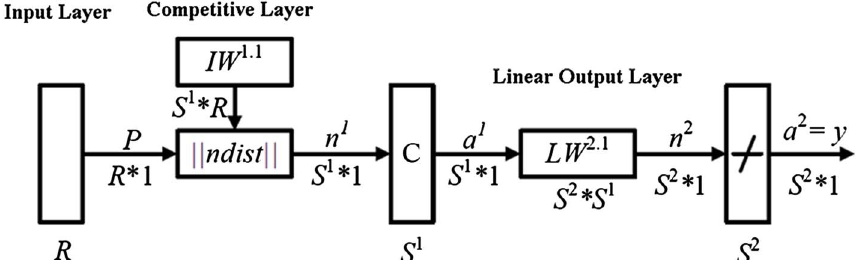
Figure 1. Architecture of the LVQ neural